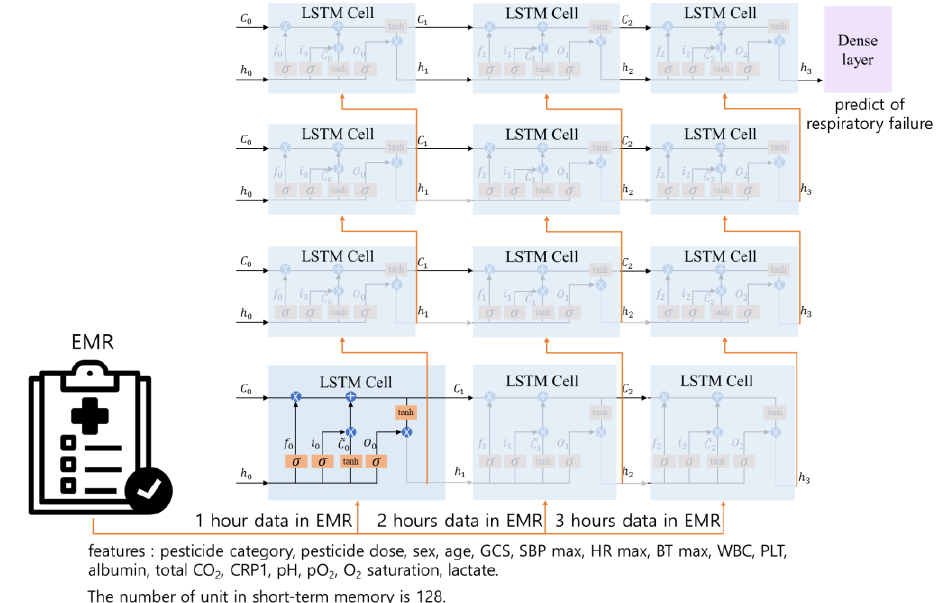
Figure 14. Structure of the LSTM model in this paper. The number of units in the LSTM layer is 128.